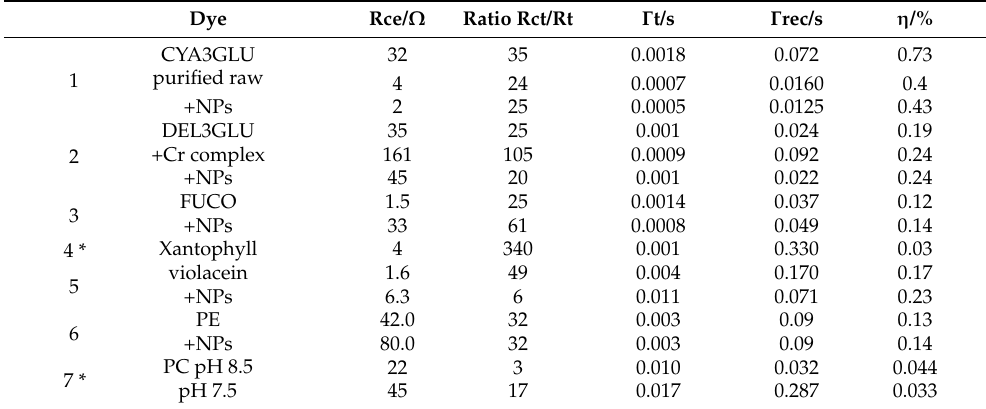
Table 2. Values obtained from fitted values at V = 0.5 V, in darkness, using a transmission line-based model (except those with * measured at 0.4 V). The resistances ratios are reported as the mean values calculated from three individual cells and using a standard deviation of 0.07. Times are expressed as mean values using relative SD = 5 × 10 − 3